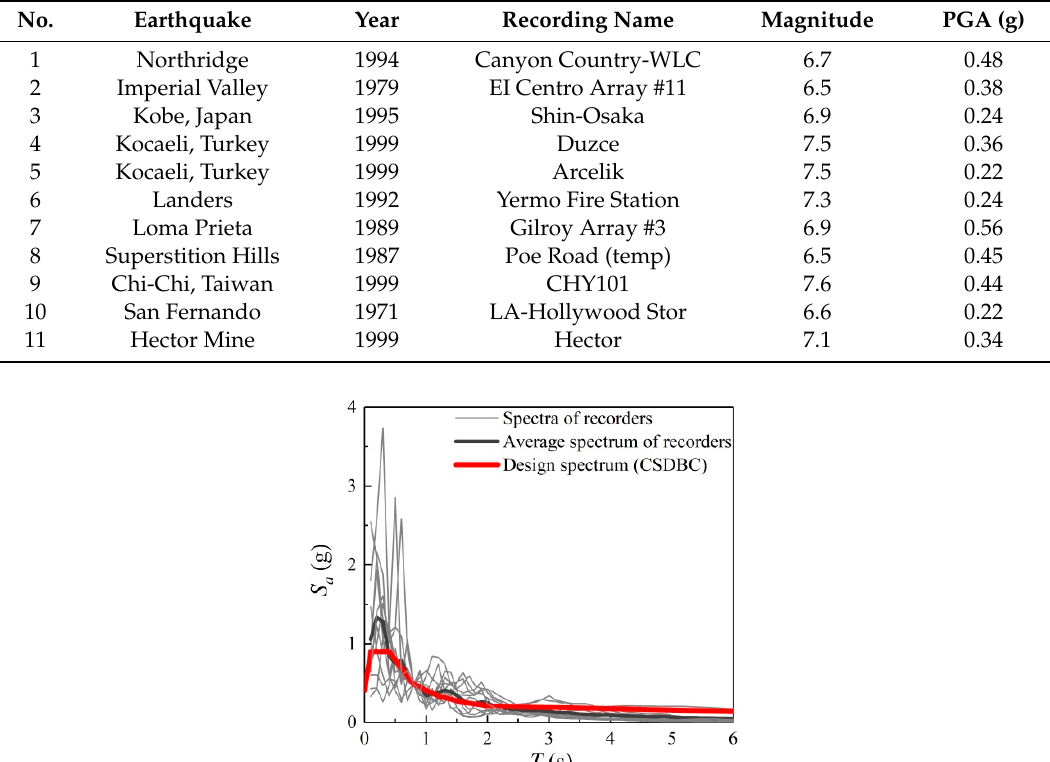
Table 2. Basic information of selected ground motions.